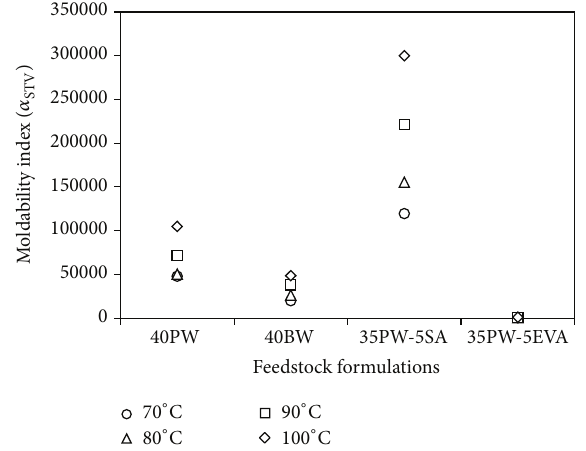
Figure 6: Moldability index ( 𝛼 STV ) of feedstocks at different tem- peratures (for ̇𝛾 ref = 1160 s −1